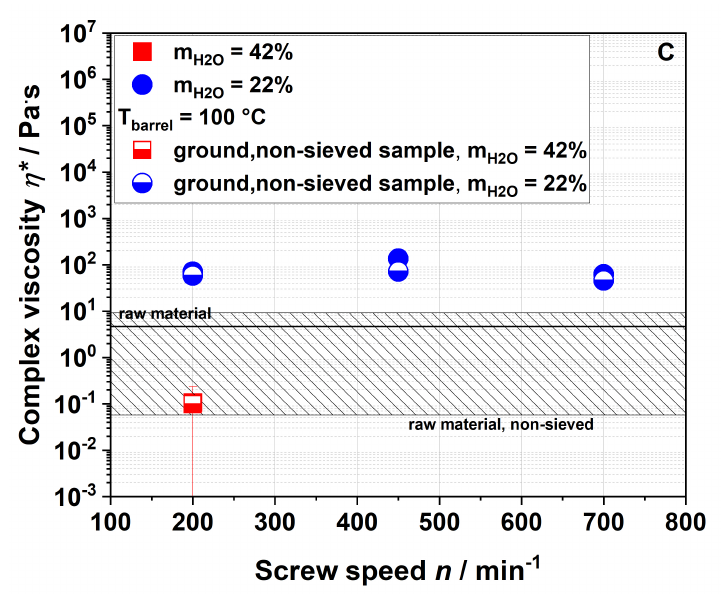
Figure 8. Water solubility index ( A ), water absorption index ( B ), and complex viscosity ( C ) of raw and extruded apple pomace for a particle fraction of 0.14–0.28 mm (filled) and the entire ground sample